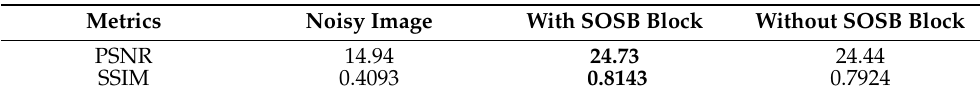
Table 10. Comparison results of with/without SOSB modules. The bold values denote the best